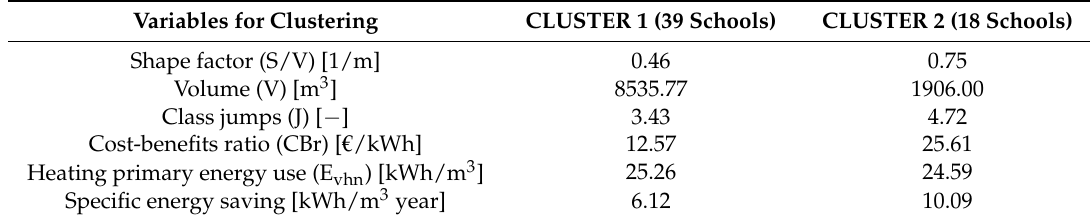
Table 3. The Centroids’ coordinates for every cluster.